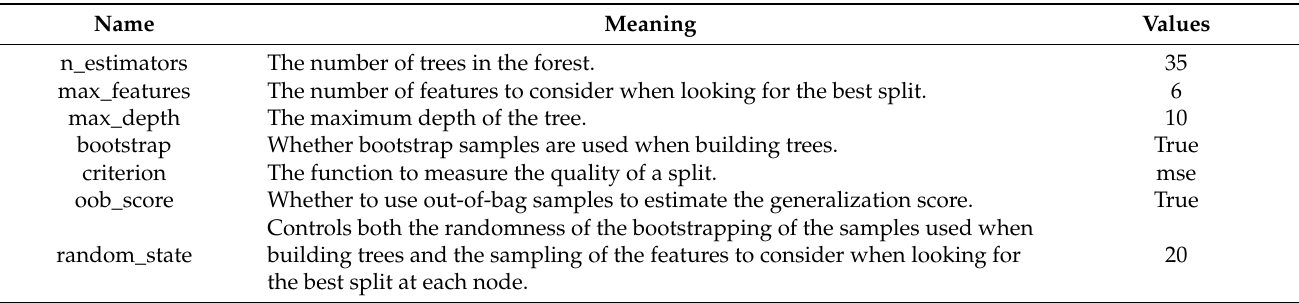
Table 2. Random forest model: parameter